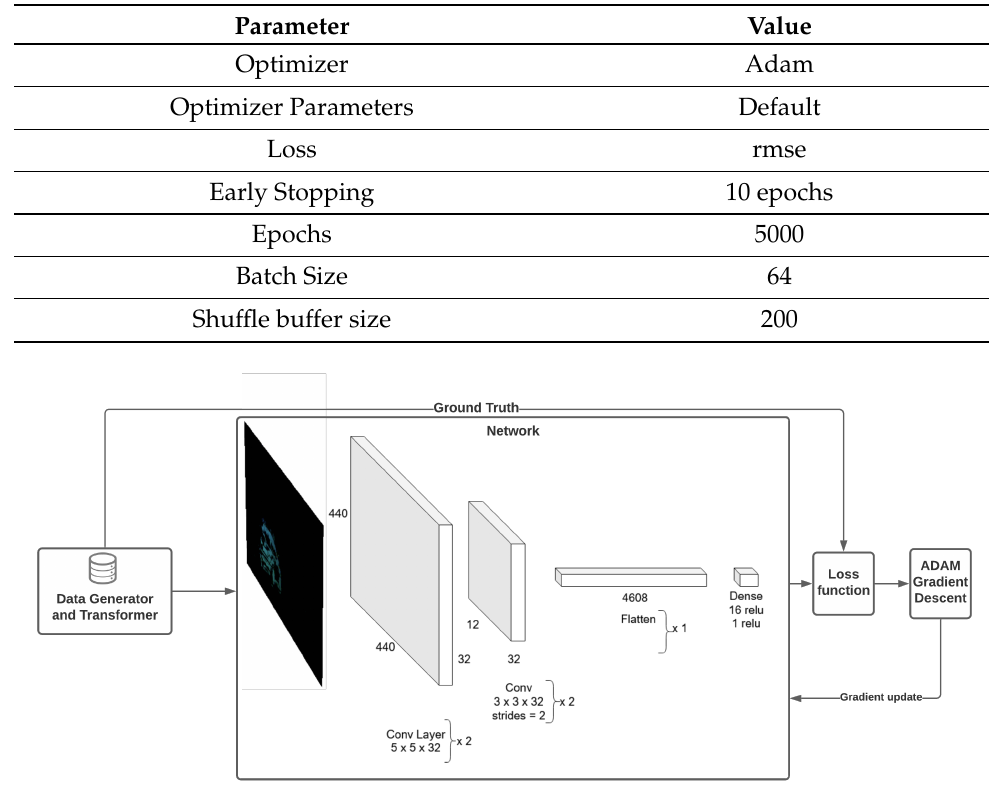
Table 4. Convolutional network hyper-parameters.